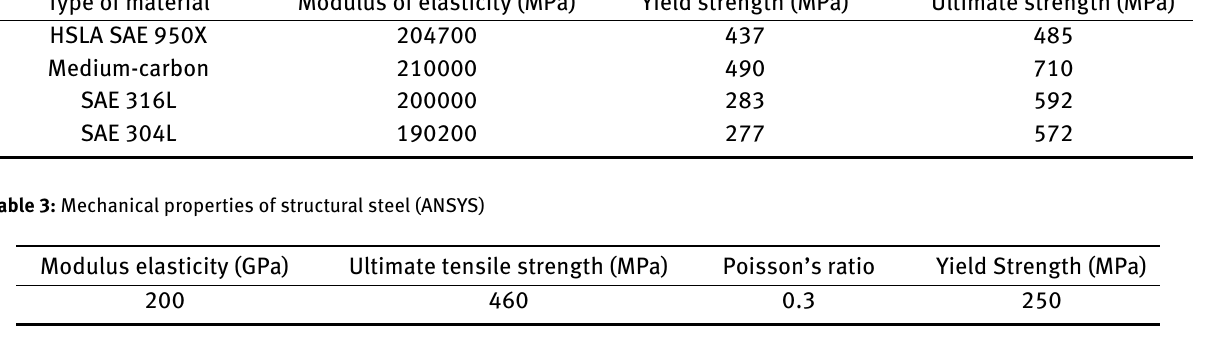
Table 2: Mechanical properties Type of material